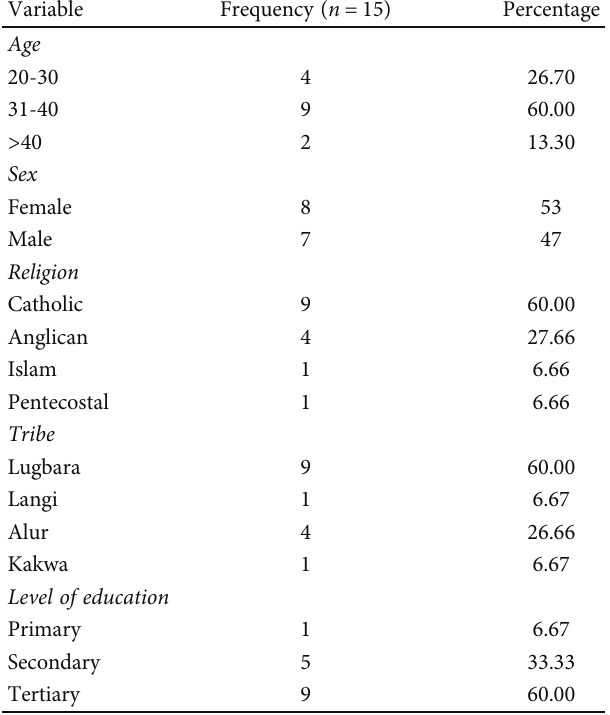
Table 1: Sociodemographic characteristics of